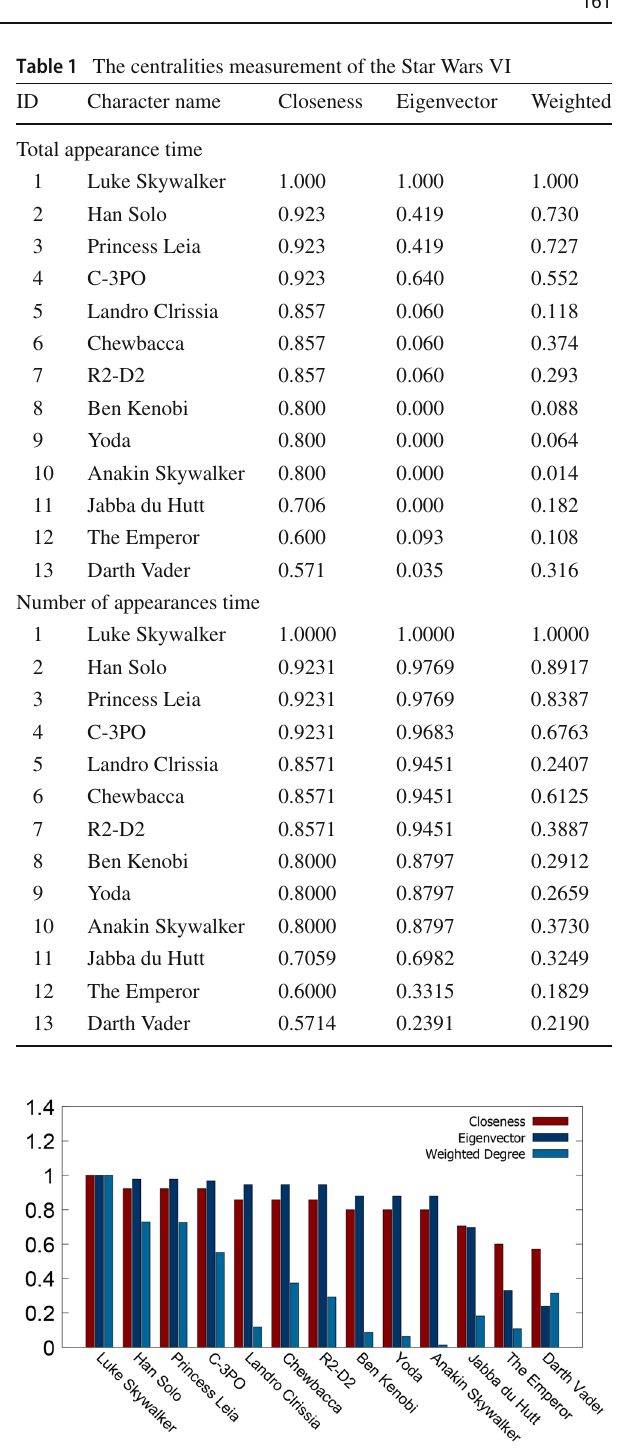
Fig.3 Thecentralitiesmeasurementresultsusingtotalappearancetime of